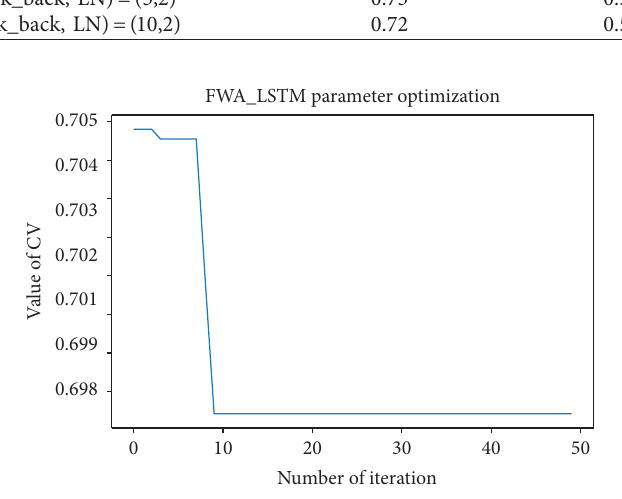
Figure 9: The change of the fitness value.